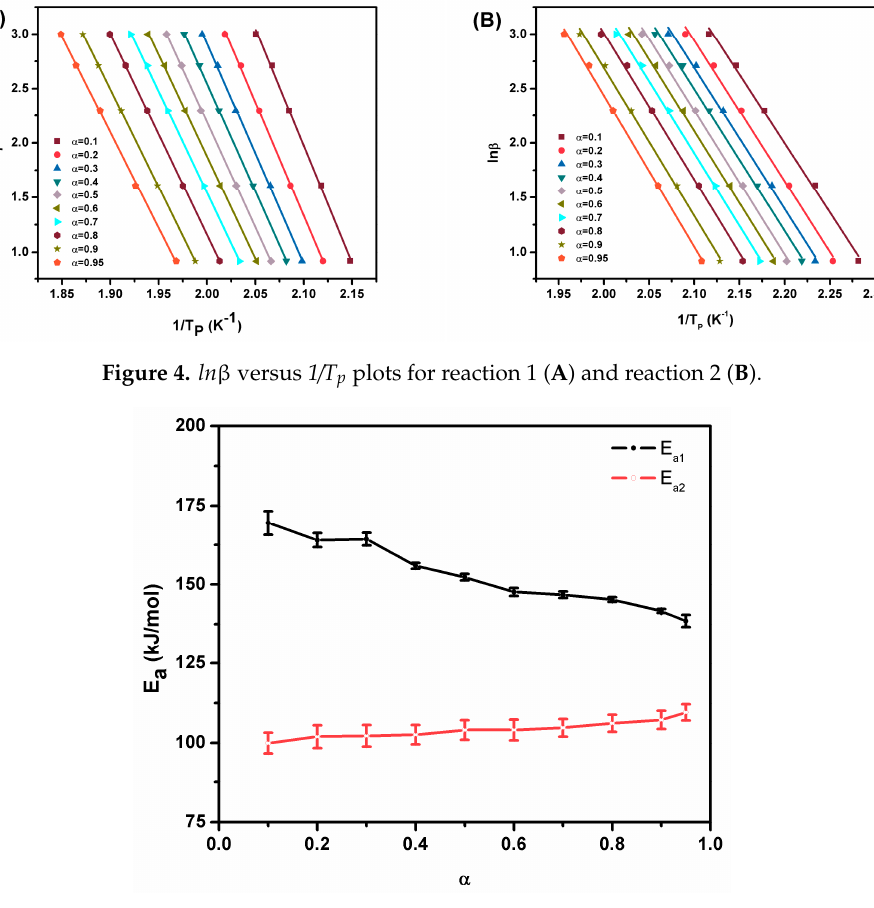
Table 3. The kinetic parameters calculated for the P-ddm/APbPc curing system. β (K/min)